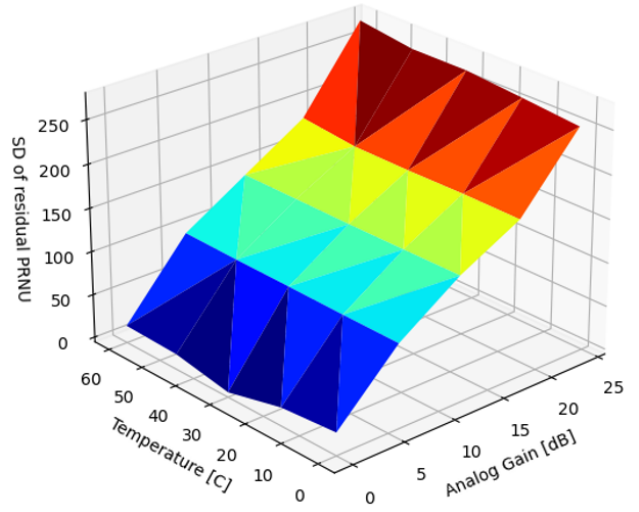
Figure 19. Residual SD of PRNU, single-reference